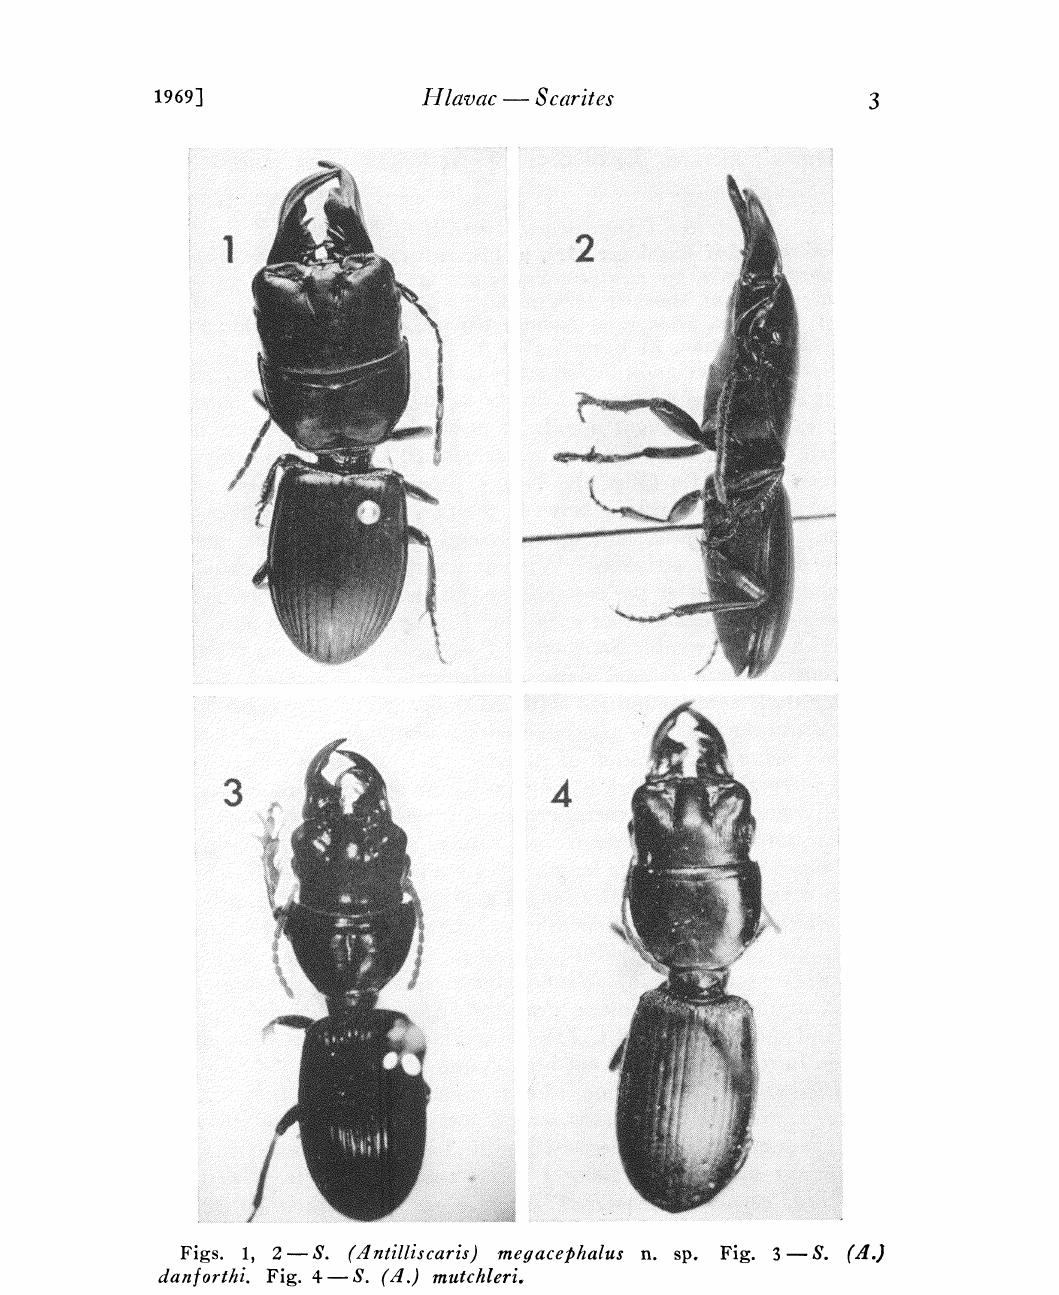
Figs. 1, 2--8. (/lntilliscaris) megacethalus n. sp. Fig. 3--S. danf orthi. Fig. 4 S. (1.)